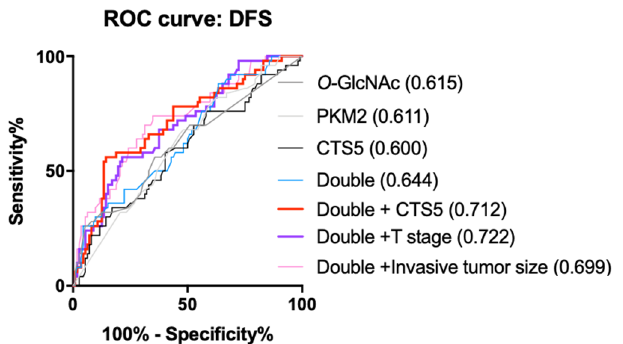
Figure 7. ROC curve analysis in HR + /HER2 − luminal BC. ROC curve analyses using the O -GlcNAc (dark grey line), PKM2 (light grey line), CTS5 (black line), PKM2– O -GlcNAc (Double, blue line) the Double–CTS5 (red line) models, the Double–T stage (purple line), and the Double–Invasive tumor size (pink line). Values in parentheses refer to the area under curve (AUC).